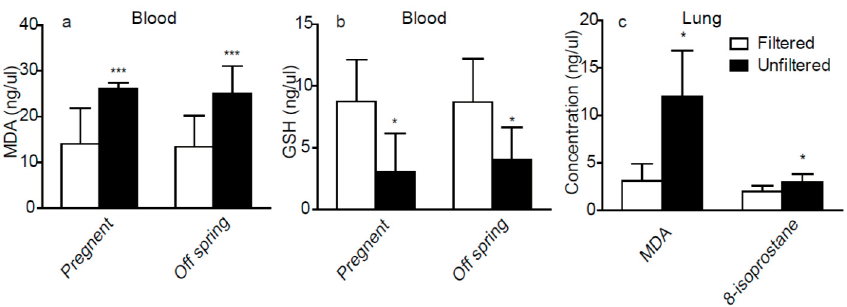
Figure 2. The oxidative stress factors in plasma and Lung. ( a ) Blood biomarkers, malondialdehyde (MDA), measured in pregnant rats and 8-week-old male pups; ( b ) Blood biomarkers, GSH, measured in pregnant rats and 8-week-old male pups; ( c ) Biomarkers of oxidative stress, malondialdehyde (MDA) and 8-isoprostane, in lungs of the 8 weeks old male pups. Significant difference between the two groups denoted as * p < 0.05, *** p < 0.001, n = 6 for each group.